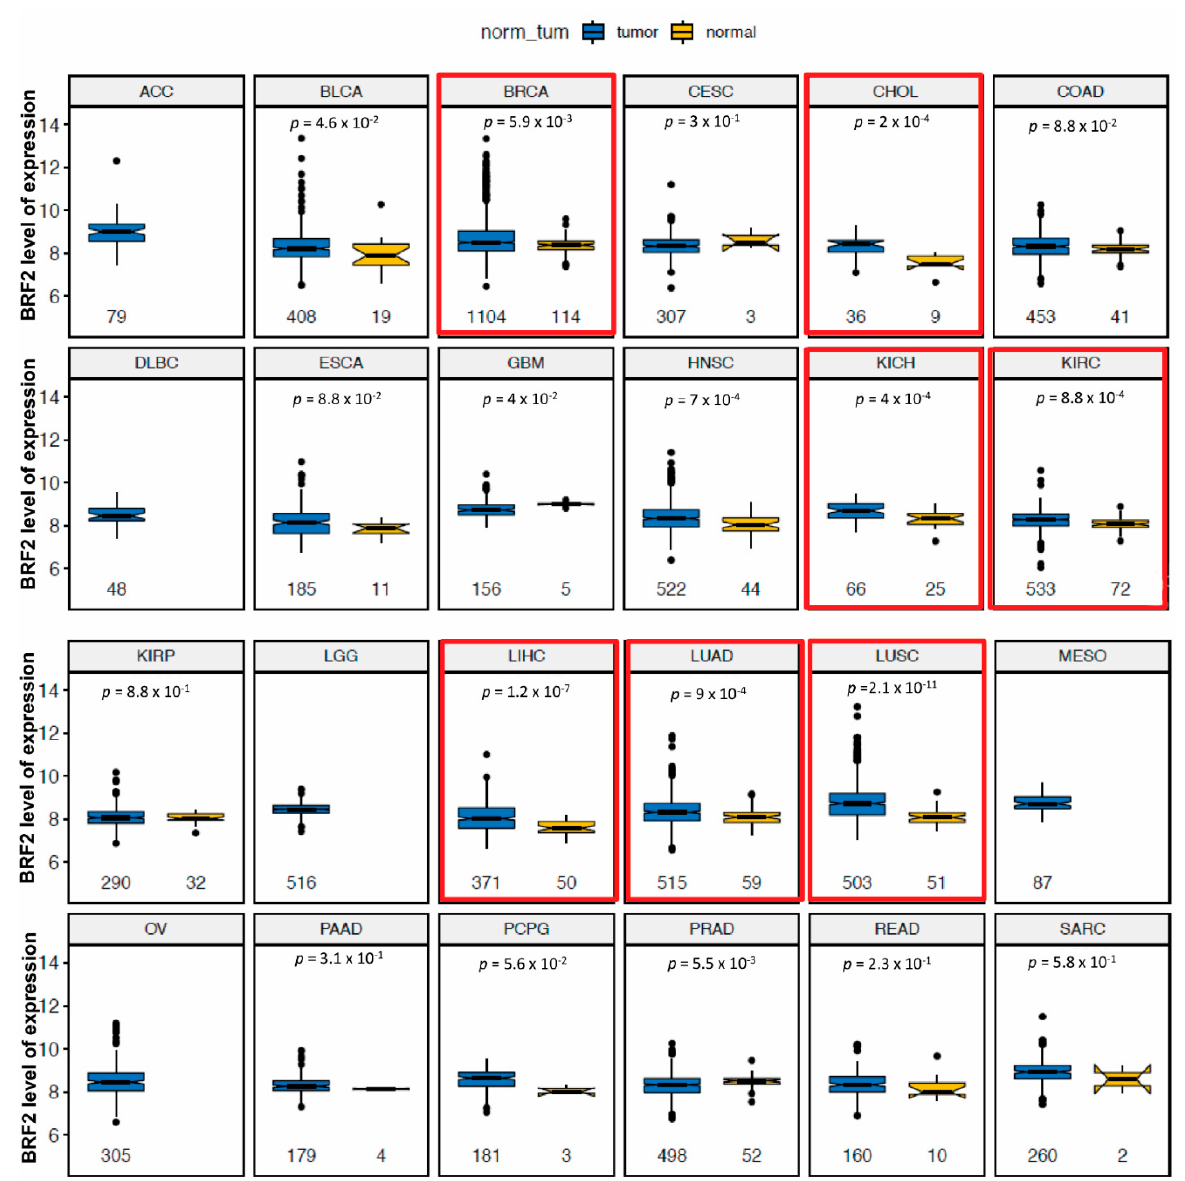
Figure 1. BRF2 elevated expression in multiple tumors. Comparison of gene expression levels in normal and tumor tissues in 24 cancer types. All data in these box plots are from The Cancer Genome Atlas (TCGA) RNAseq datasets. The box plots compare mRNA expression levels for the indicated gene ( y -axes) between tumors and matched adjacent normal tissues ( x -axes) of 24 cancer types. The abbreviations in the grey bars on top refer to the cancer types. Sample sizes (n) are shown below each box. Normal samples are missing for a few cancer types. The p -values were calculated using the (unpaired) Mann–Whitney U test. (For cancer type abbreviations, see the Supplementary Data).